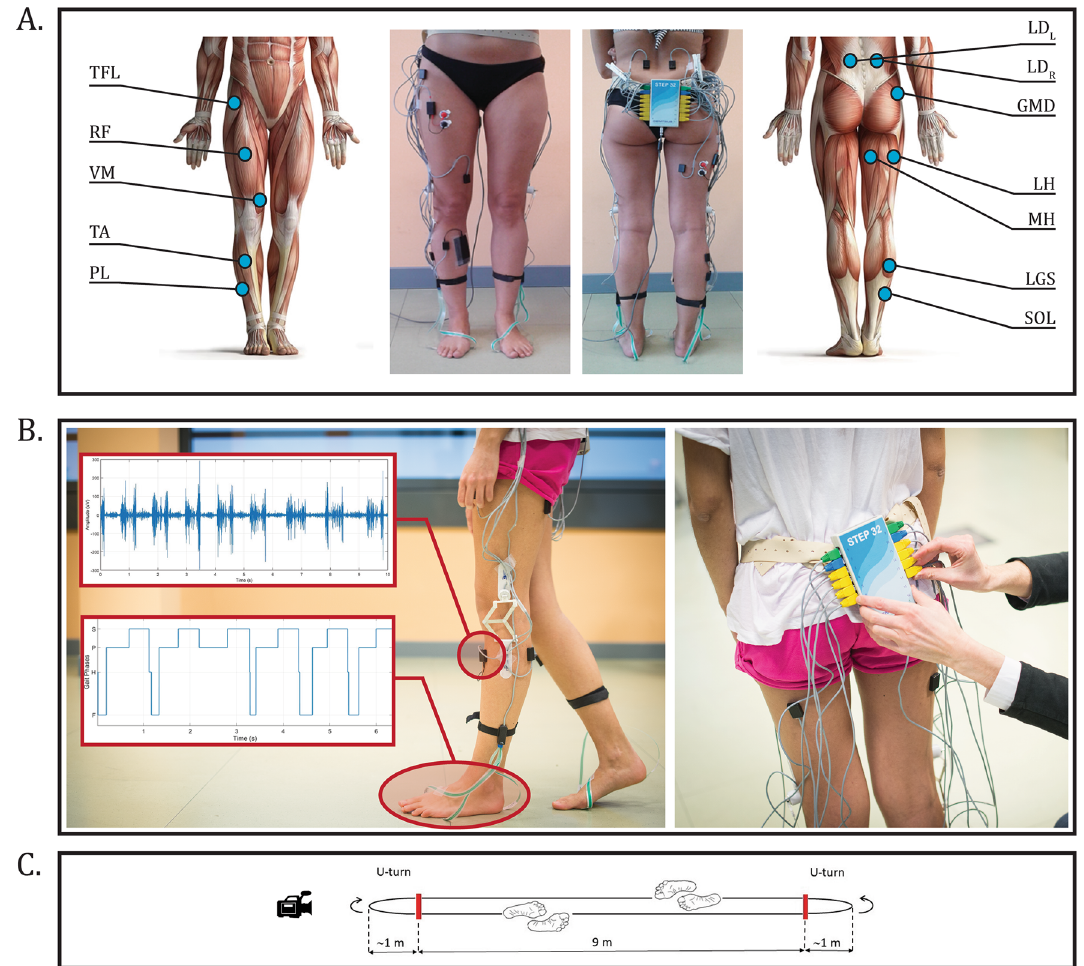
Figure 4. Experimental design and data recordings. ( A ) Sensor placement for a healthy representative subject of the sample population. SEMG active probes are placed over twelve muscles of the dominant (or more affected) lower limb and the trunk (bilaterally). Foot-switches are placed beneath the heel, the first, and the fifth metatarsal heads to detect gait phases. Electro-goniometers are placed on the lateral aspect of the knee joint, bilaterally. ( B ) Examples of sEMG (upper panel) and foot-floor contact (lower panel) signals acquired through the system STEP32 (Medical Technology, Turin, Italy). ( C ) Schematic representation of the walking path. Subject walked barefoot back and forth along a 9-m straight path, for approximately 5 min at a self-selected